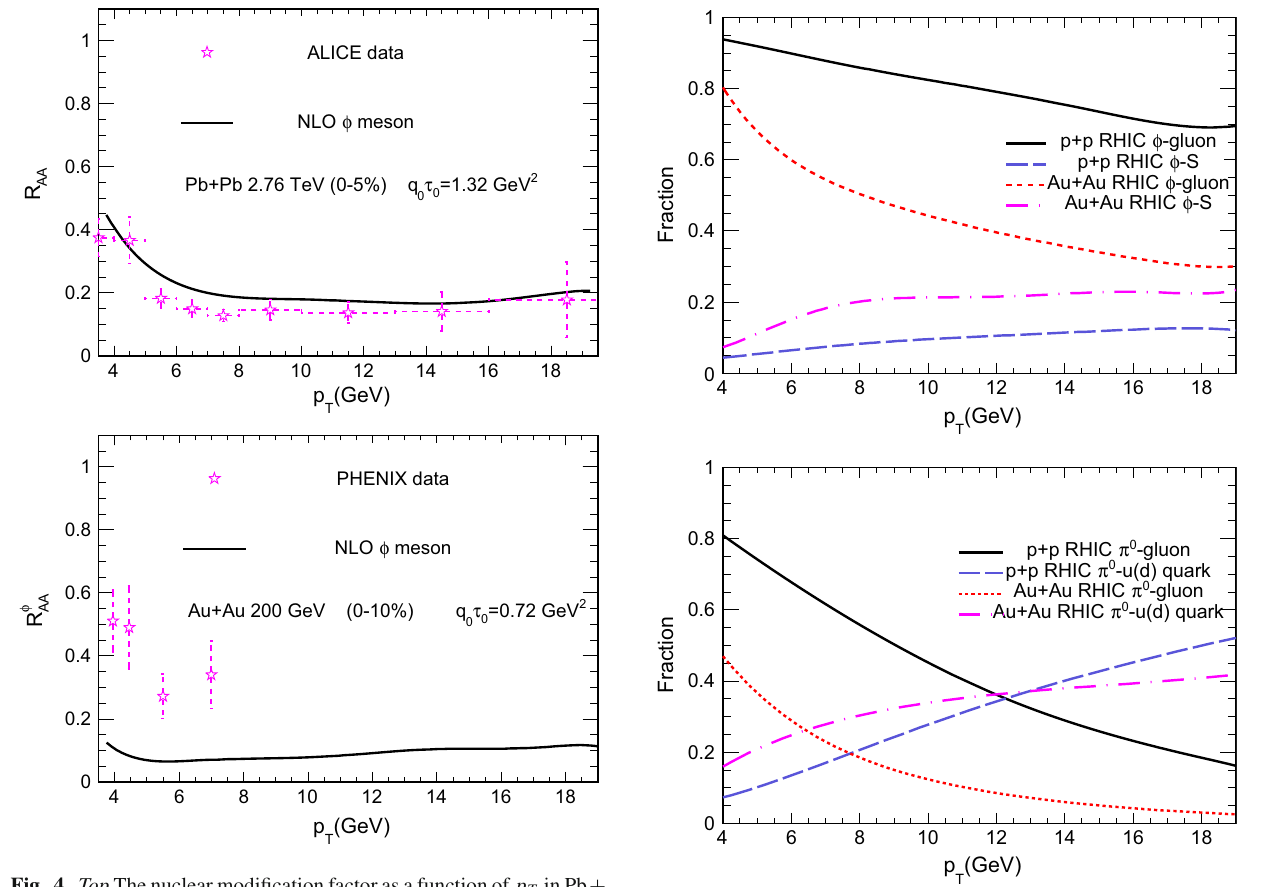
feature is in striking contrast with the productions of π 0 , η and ρ 0 . As a comparison in the bottom panel of Fig. 5 we show the only gluon (strange quark) fragmenting contribu- tion fraction of π 0 production in p + p collision at the